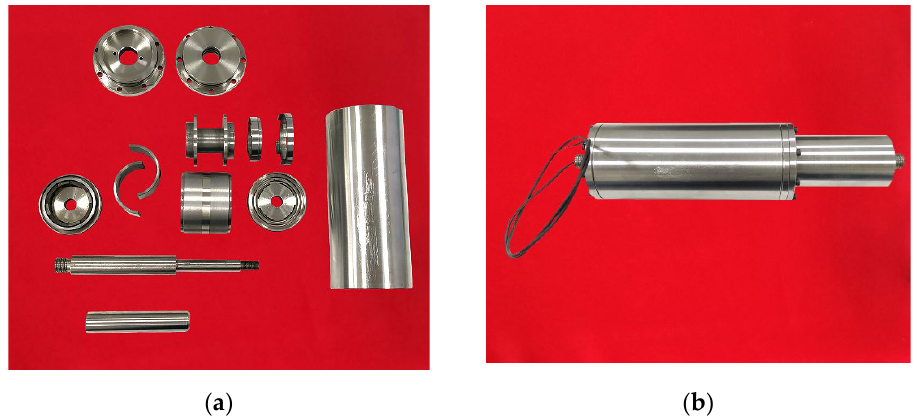
Figure 12. Proposed MR damper with folded resistance gaps and bending magnetic circuit: ( a ) Components; ( b ) Prototype.